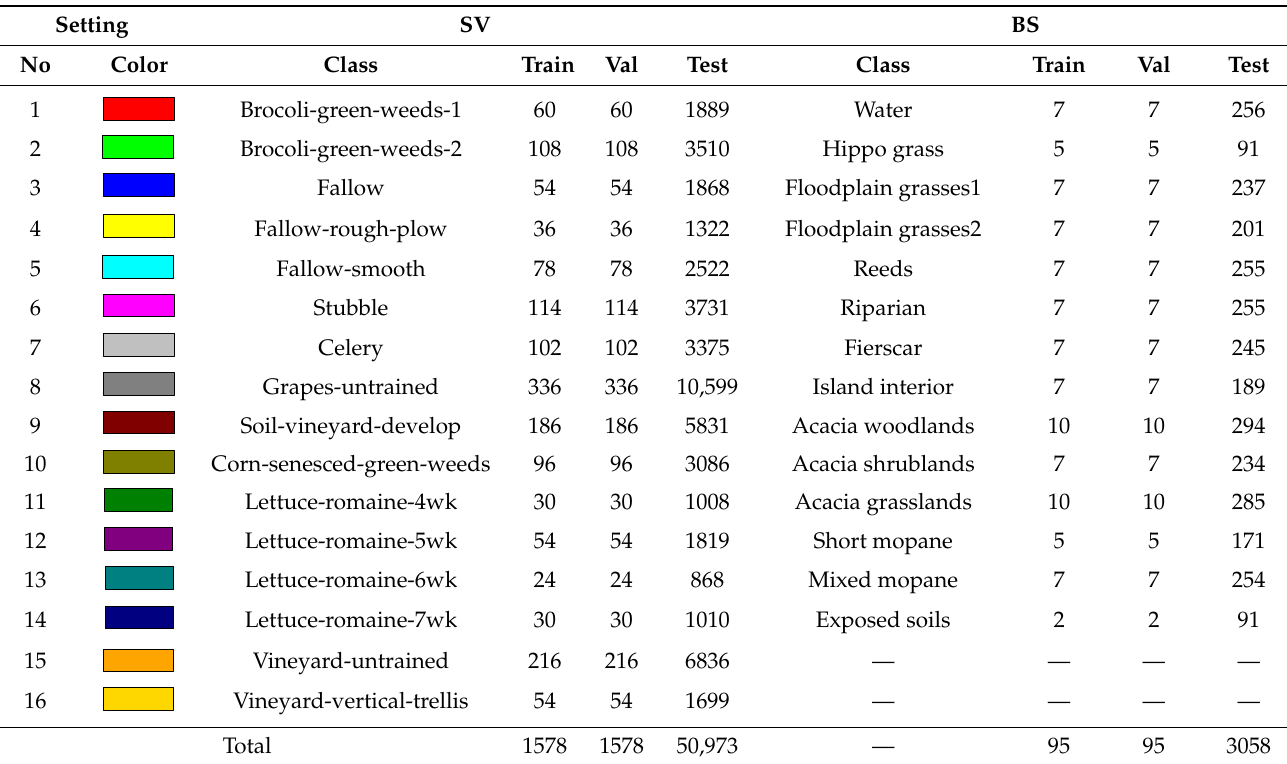
Table 2. Land cover category and number of samples for training, validation, and testing of SV and BS.